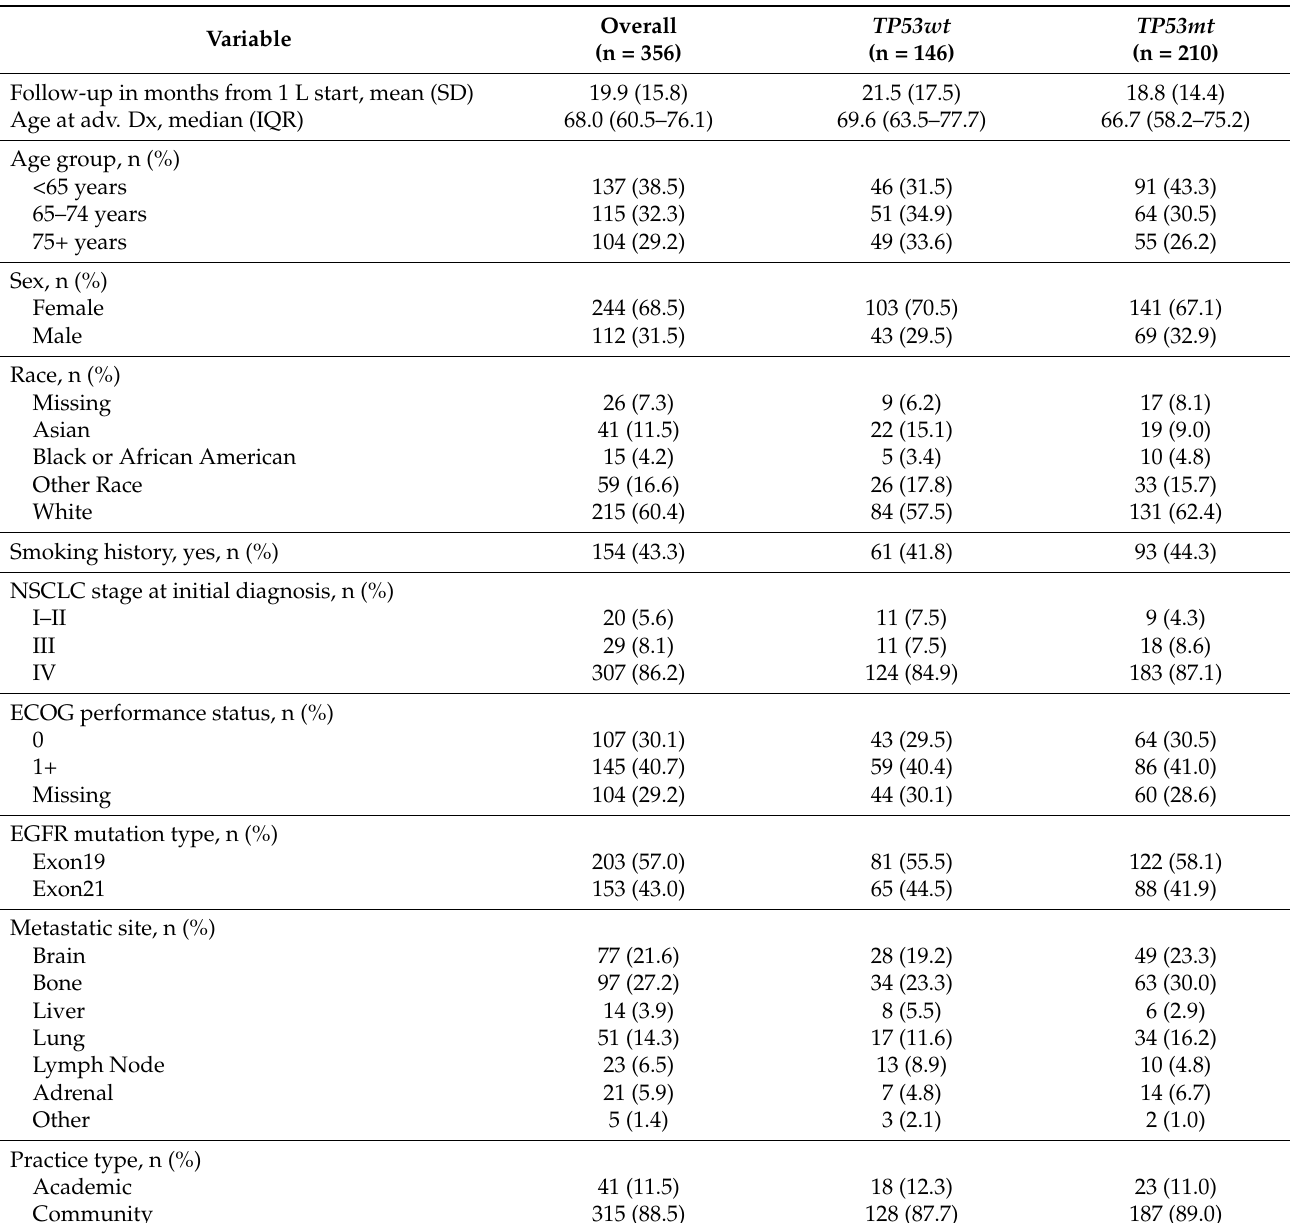
Table 1. Patient demographic and clinical